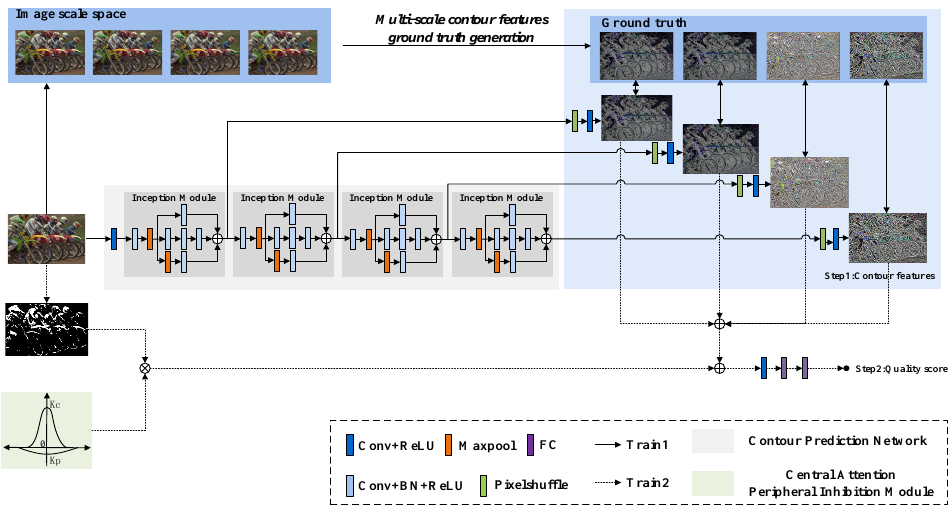
Figure 1. Illustration of the MSIQA model. The model consists of a multi-scale Contour Prediction Network and a Central Attention Peripheral Inhibition Module. The solid line is the first step of training, and the dashed line is the second step of training.